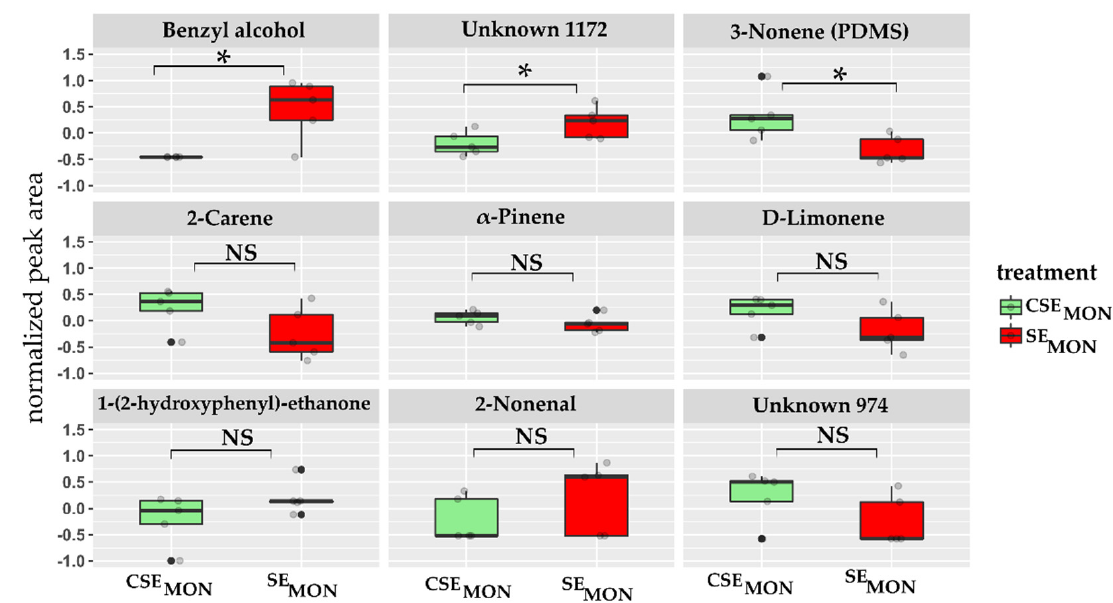
Figure 4. Peak areas of main compounds detected in control CSE MON (green) and herbivory-stressed SE MON (red) S. lycopersicum roots. All compounds were detected with HiSorb except for 3-nonene (PDMS). Each box-plot depicts the distribution and median (horizontal line) of normalized and log10 transformed peak area of five replicates per treatment. Boxplots indicated with an asterisk (*) differ statistically ( p < 0.05), whereas box-plots indicated with NS did not show statistically significant differences.